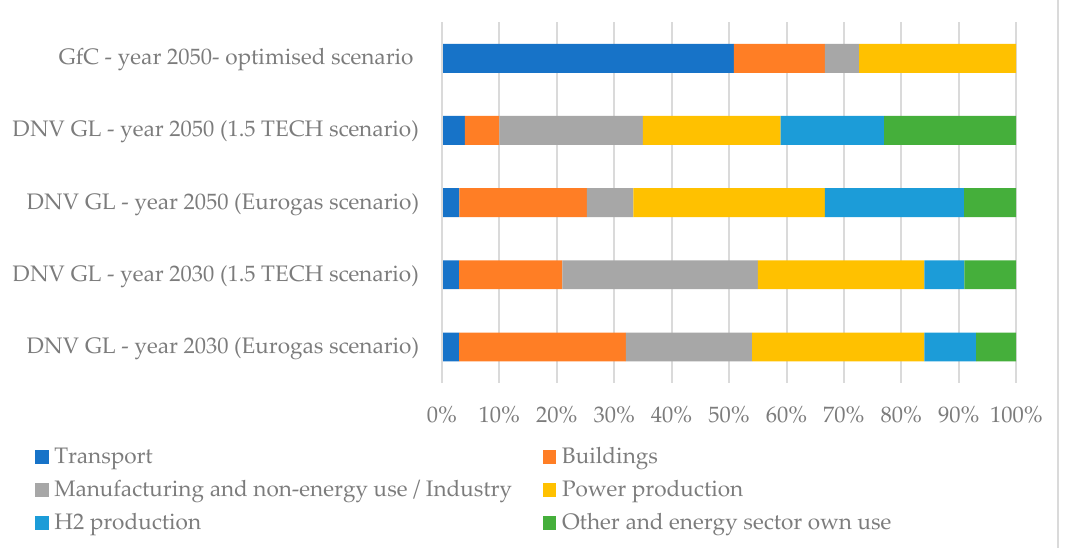
Figure 11. The expected structure of demand for biomethane in 2030 and 2050 in the EU. Source: own elaboration based on Kate et al. and Terlouw et al. [56,85]